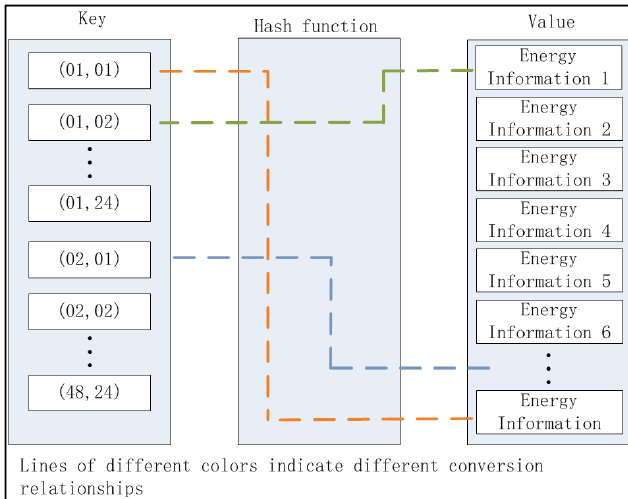
Figure 7. Hash table diagram.